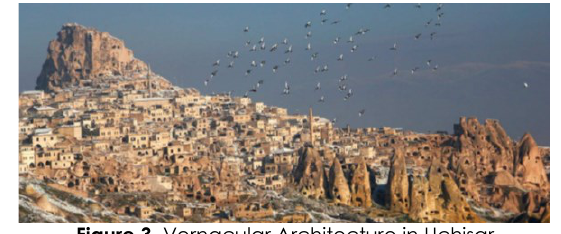
Figure 3. Vernacular Architecture in Uçhisar (Uchisar Municipality, 2019b).